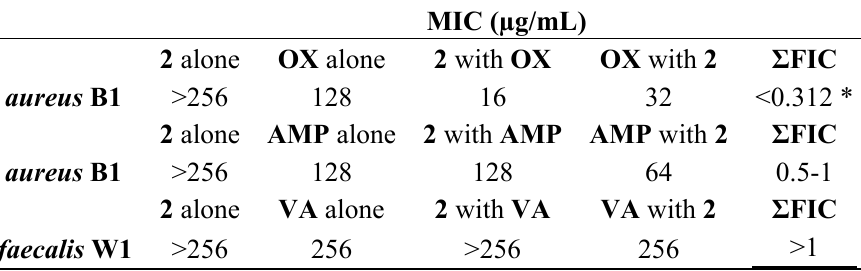
Table 3. MIC value of 1,7-dihydroxyxanthone ( 2 ) in combination with oxacillin (OX), amplicillin (AMP) or Vancomycin (VA), and respective fractional inhibitory concentration (FIC) index obtained against a MRSA ( S. aureus B1) or VRE ( E. faecalis W1) by a checkerboard